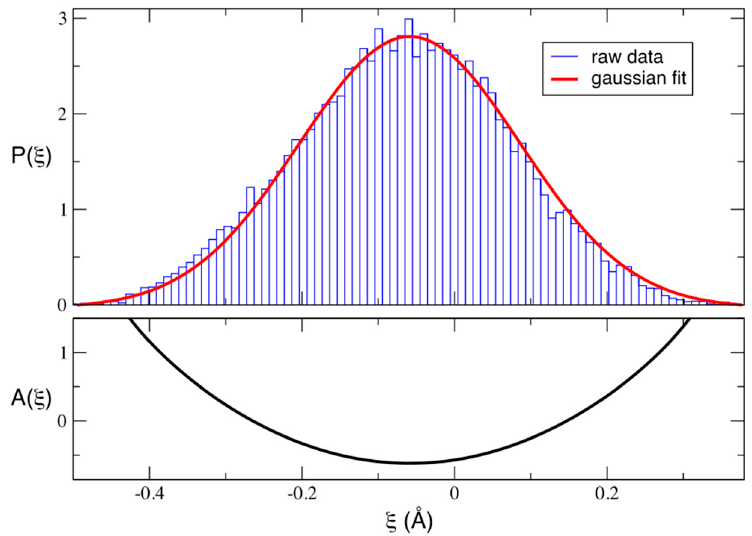
Figure 5. Upper panel: Normalized probability distribution, P ( ξ ) computed using equidistant frames extracted from the quantum mechanical/molecular mechanical (QM/MM) trajectory. The raw distribution is shown as a histogram, built using a bin width of 0.01 Å. A gaussian fit to the histogram is also displayed. Lower panel: Potential of mean force, A ( ξ ) in kcal mol − 1, estimated by Boltzmann inverting the gaussian fit: A ( ξ ) = − K B TlnP ( ξ )